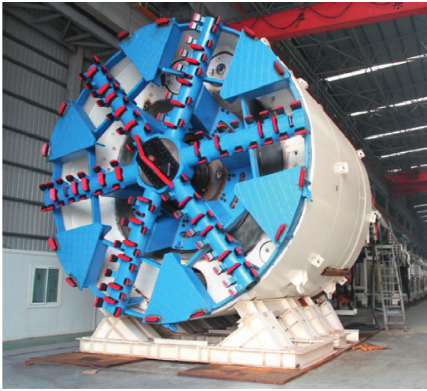
Figure 31: Picture of EPB shield.